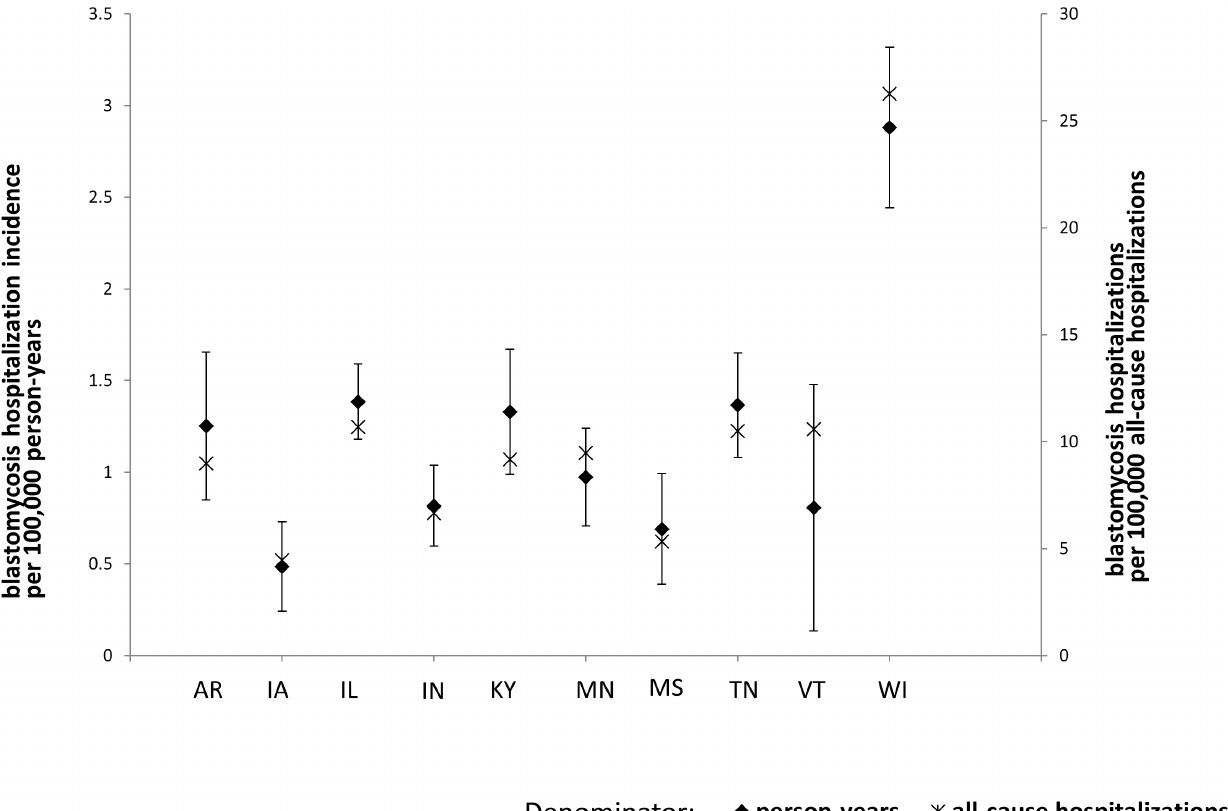
Figure 2. Blastomycosis-associated hospitalization incidence and rate of blastomycosis hospitalizations per all-cause hospitalization.